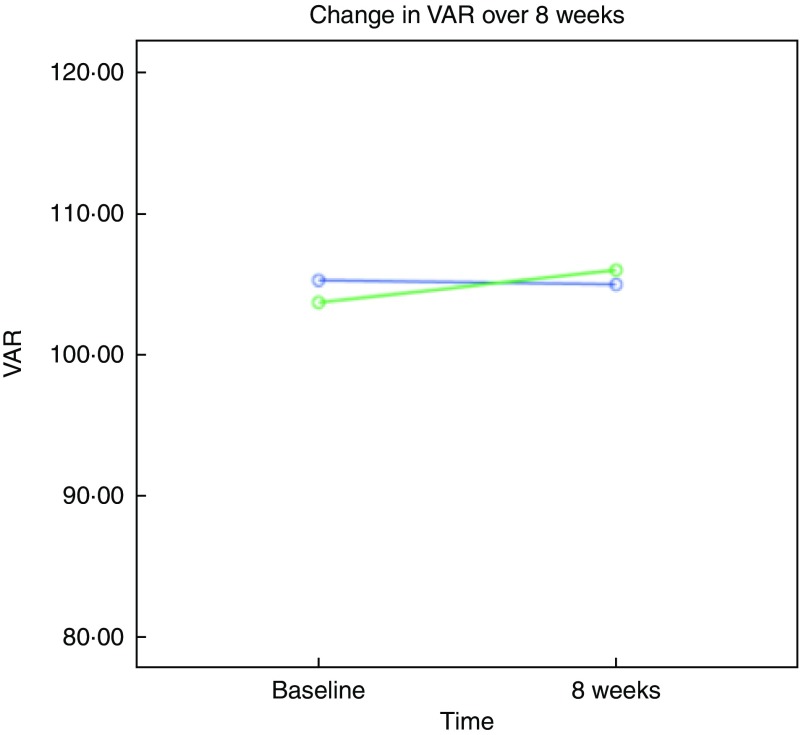
Change in best corrected visual acuity (BCVA) rating values between baseline and
final visit (8 weeks) measured with Test Chart 2000 Xpert (Thomson Software
Solutions) in the Egg Xanthophyll Intervention Trial; control egg group subjects
(); one standard egg per day. Enriched egg
group subjects (); one
lutein:meso-zeaxanthin enriched egg per day. An improvement in BCVA
at final visit in the enriched egg group relative to the control group is reflected
in the higher visual acuity rating (VAR).